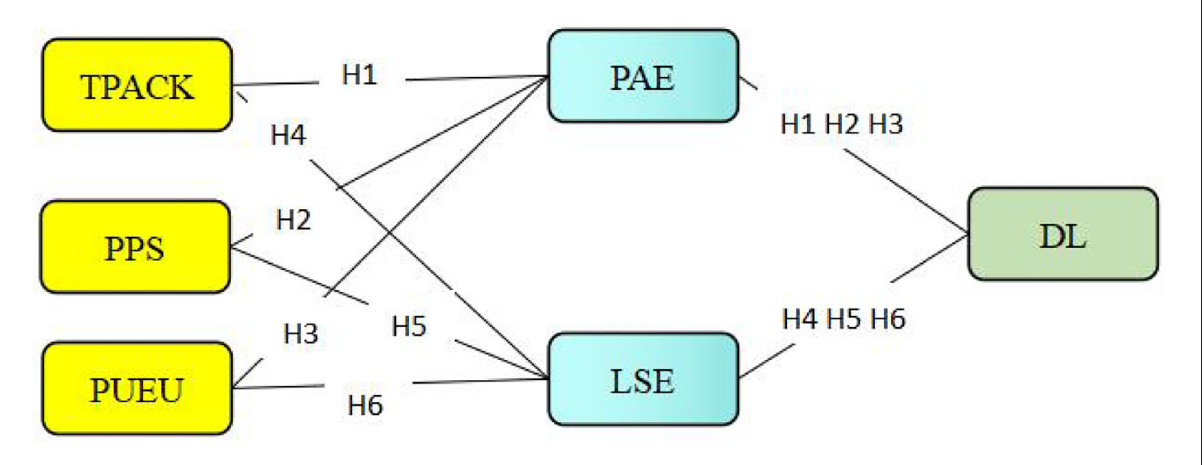
FIGURE1 The proposed